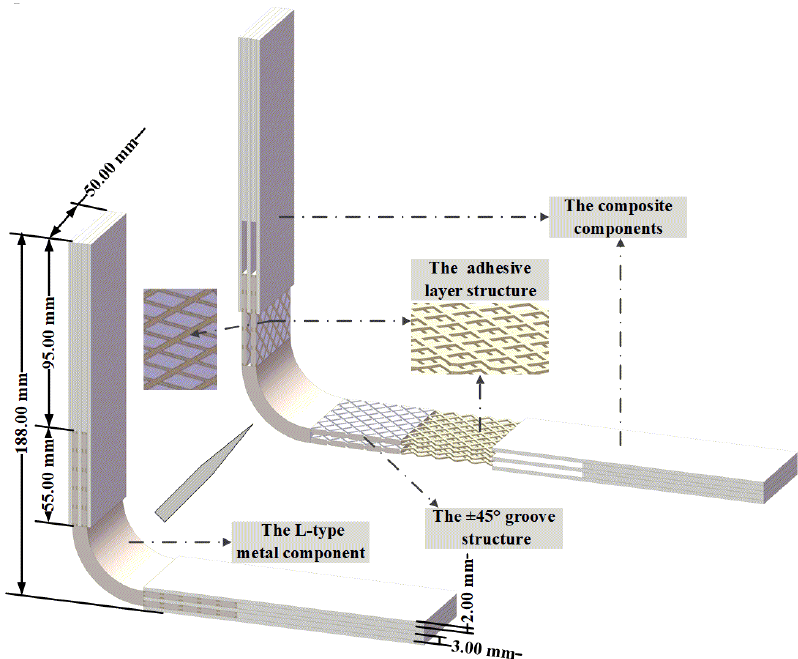
Figure 4. Disassembly schematic diagram of L-joint overall schematic and component.